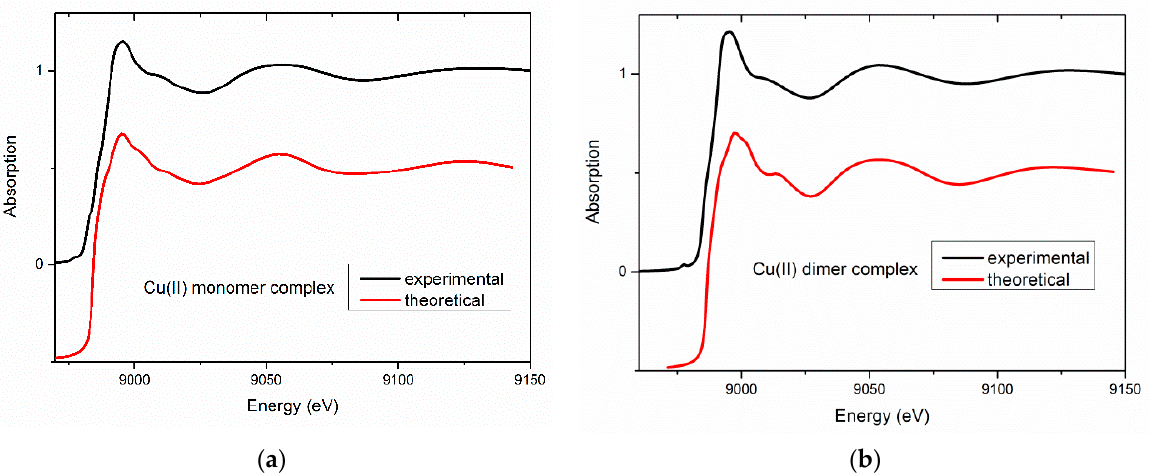
Figure 10. Calculated XANES spectra for the most energy-stable optimized models vs. experimental data for ( a ) Cu1 —representative for monomeric alkylphenyl complexes (left) and for ( b ) Cu5 —belonging to the dimeric complexes with halogenphenyl moiety.